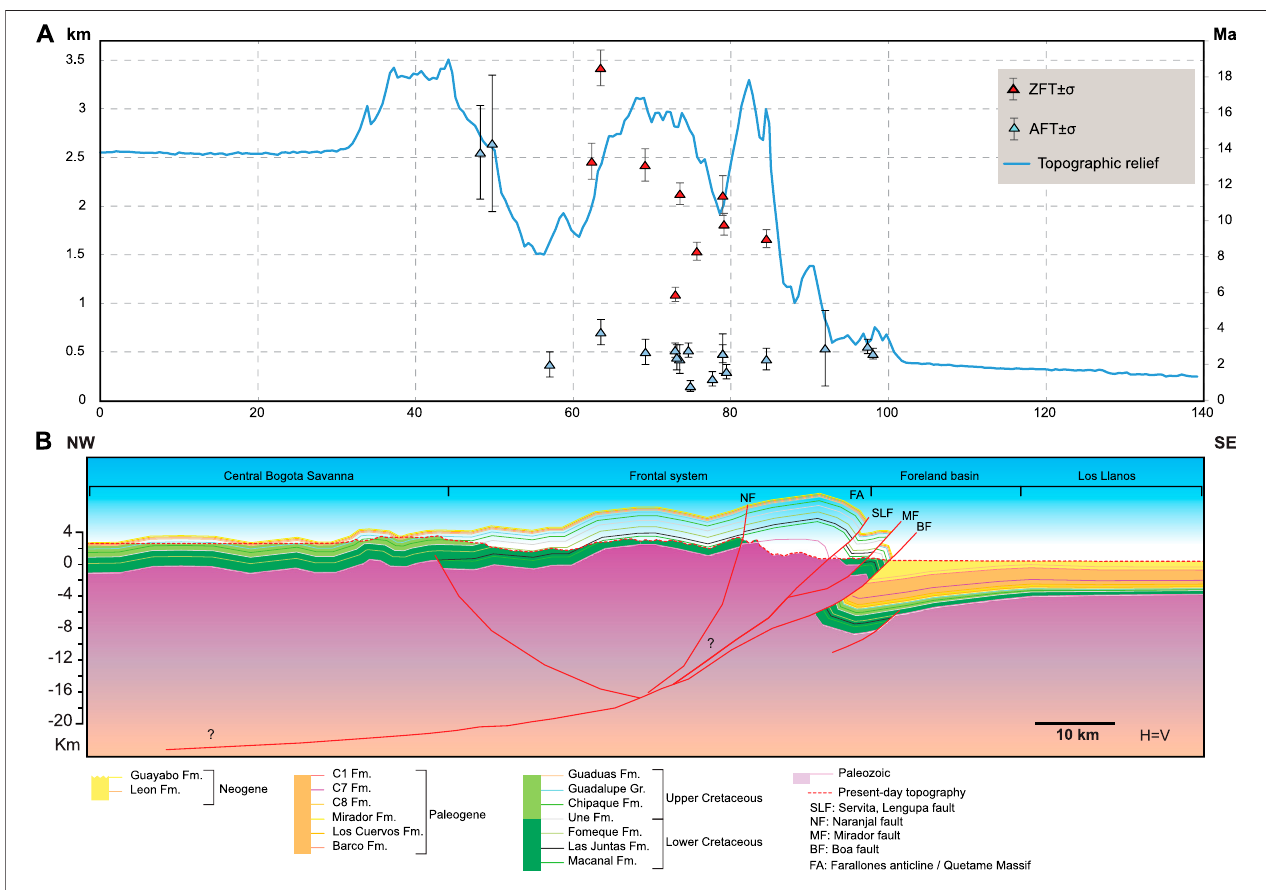
FIGURE 8 | (A) Distribution of the thermochronometric data along Section 1. (B) 2D section construction and balancing of Section 1 (see location in Figure 5 ).